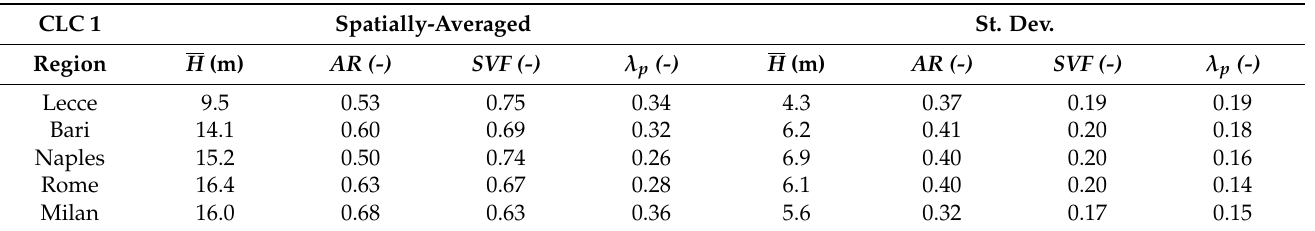
Table 2. Spatially-averaged values and standard deviations of the morphological parameters over the CLC 1 area.